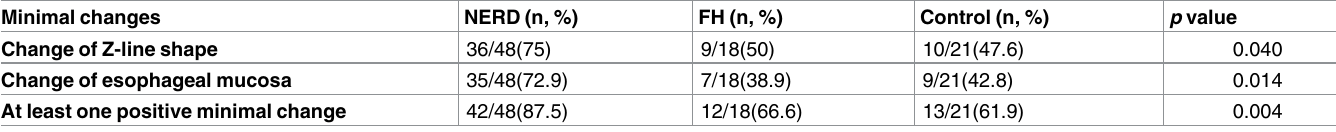
Fig 2. Minimal changes of NERD patients diagnosed using i-scan endoscopy with esophageal enhancement. A. Blurring Z-line (yellowarrow), unevenand friable mucosa at the squamo-columnar junction (red arrow). B. columnarislands(red arrow) and white mucosal turbidity (yellowarrow) was seen abovethe Z- line. https://doi.org/10.1371/journal.pone.0175263.g002 Table 2. Frequency of minimal changes in NERD group, FH group and